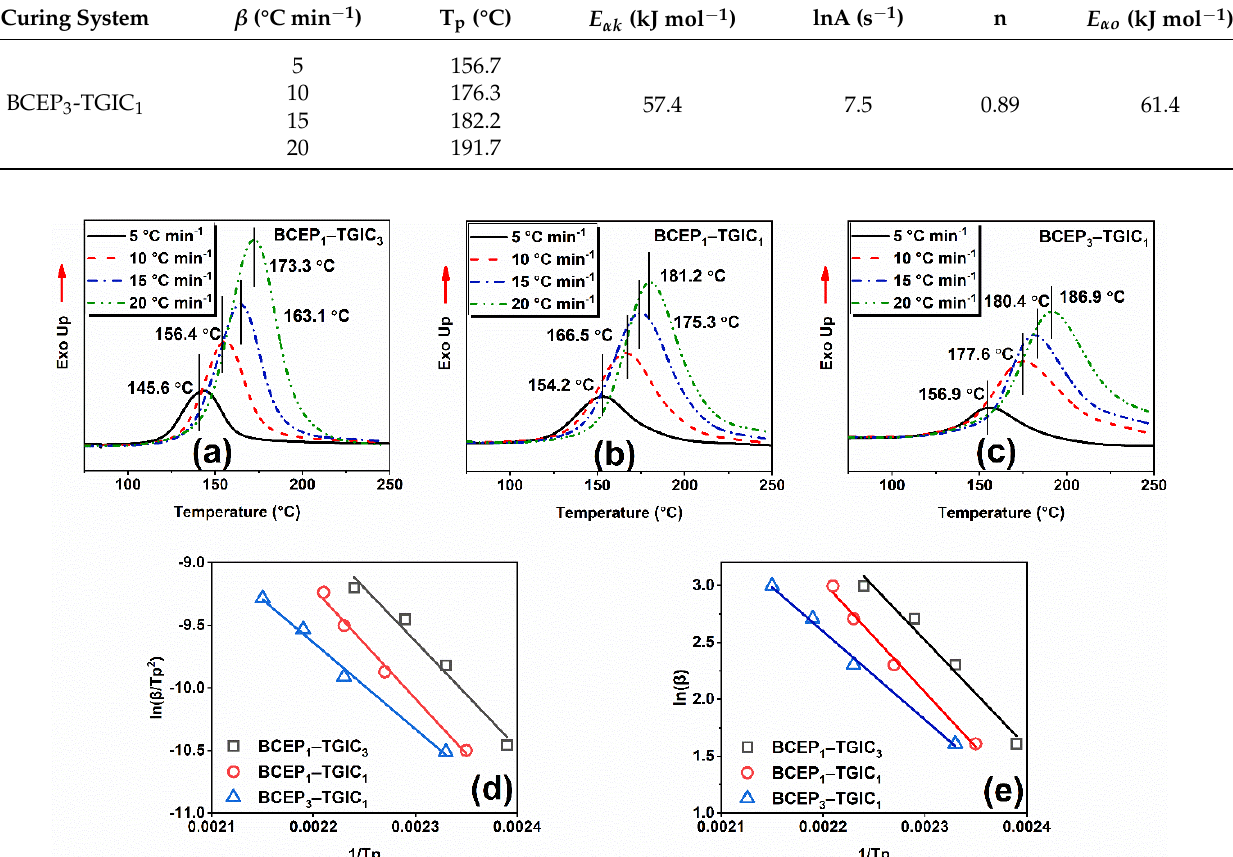
Figure 2. Non-isothermal DSC curves of BCEP – TGIC ( a – c ) with different heating rates, linear fitting plots of ln(β/T p2 ) versus 1/T p according to the Kissinger equation ( d ), and ln(β) versus 1/T p according to the Ozawa equation ( e ) for BCEP – TGIC. Table 1. Curing kinetic parameters obtained from non – isothermal DSC scans.